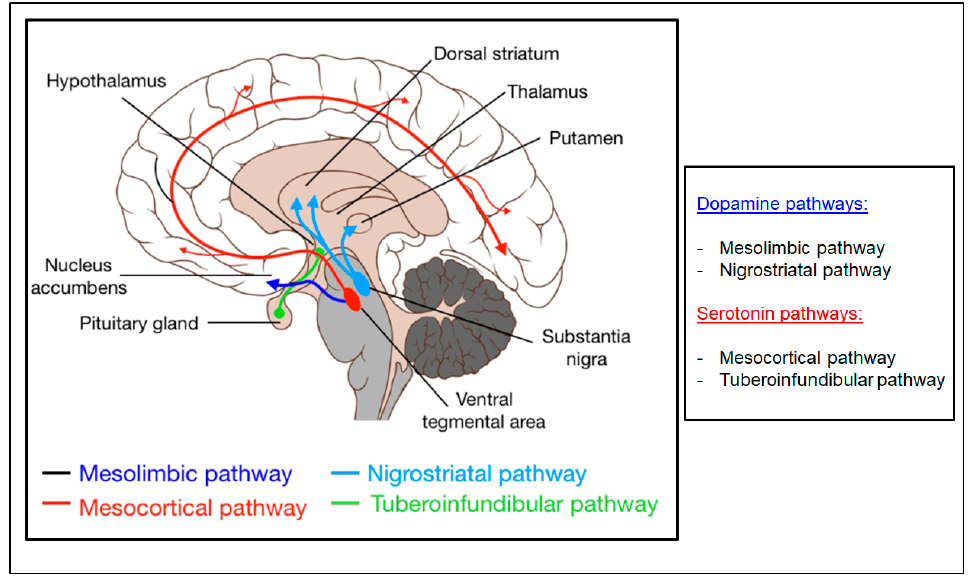
Figure 1. The main dopaminergic pathways in the central nervous system.